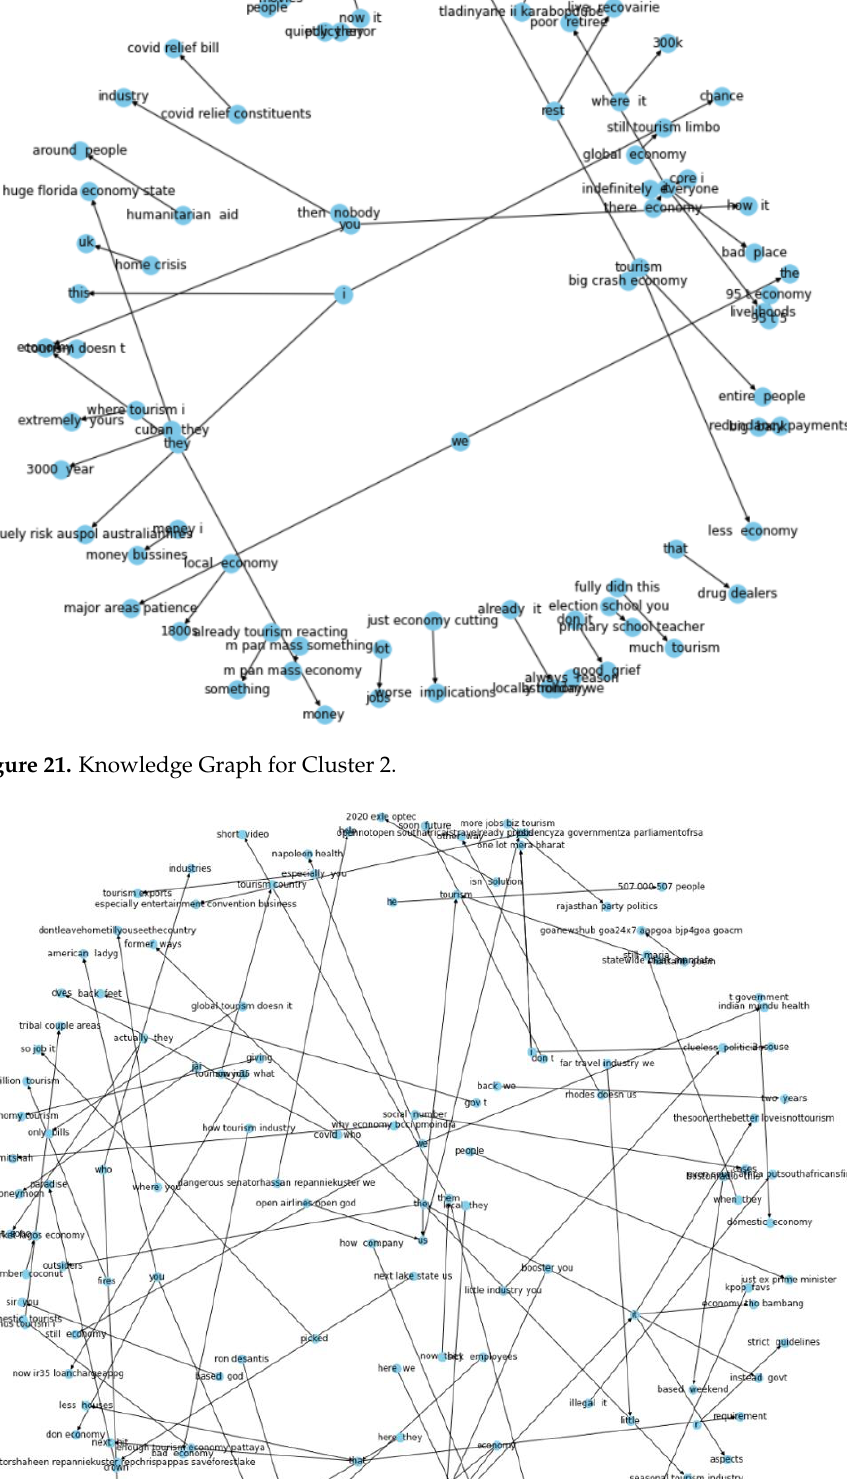
Figure 20. Knowledge Graph for Cluster 1.